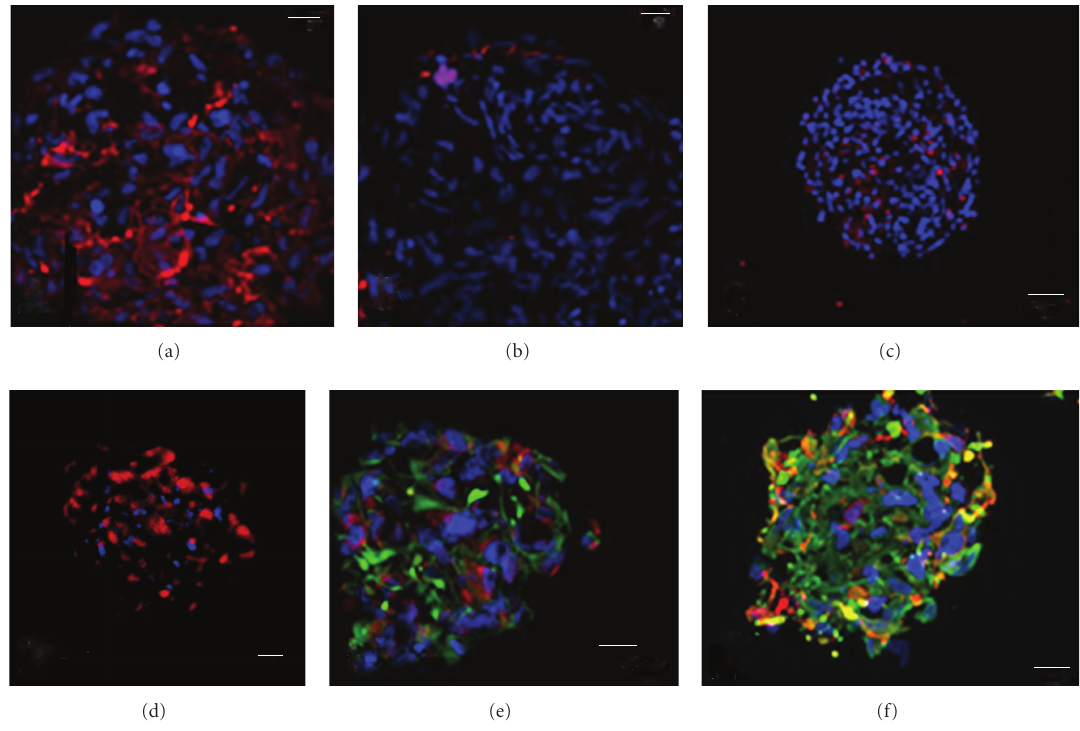
Figure 3: Expression of some proteins in tumourspheres. Tumourspheres from glioblastoma were mainly negative for the aquaporins 4 and 9 but were positive for immature and glial markers. (a, b) A few tumourspheres were weakly positive for aqp4 (a, red) but most were negative (b). (c) Few sphere cells were found to express aqp9. (d) Many sphere cells expressed aqp1. (e) A sphere showing the immature markers nestin (green) and Sox2 (red). (f) A sphere stained for nestin (green) and GFAP (red). Scale bars: (a, b, d, and e) 20 μ m; (c) 50 μ